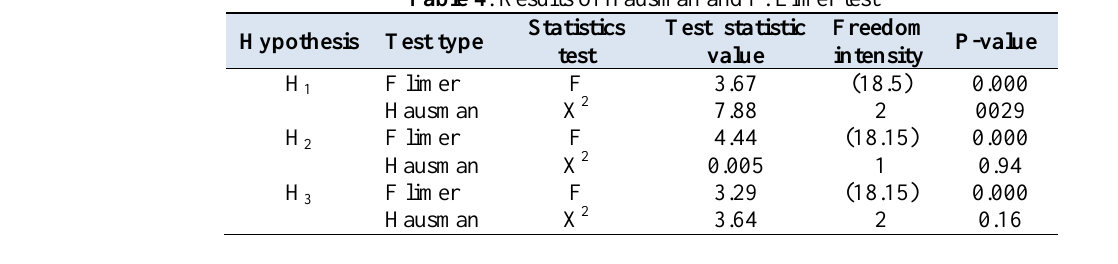
Table 5 . Results of variance heterogeneity and autocorrelation of error terms Hypothesis